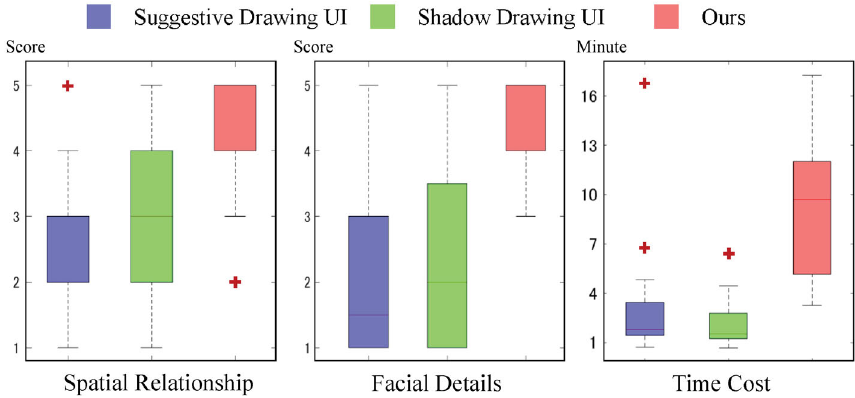
Fig. 9 Left, center: evaluation results of spatial relationship and facial details in portrait drawings. Right: time to complete portrait sketching for each drawing